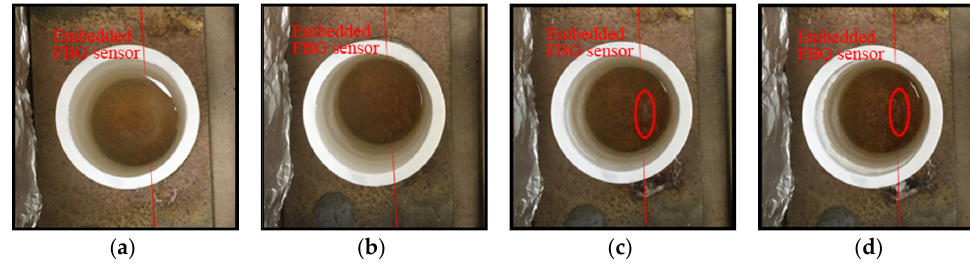
Figure 17. Visual inspections of Sample #4. ( a ) Day 1; ( b ) Day 2; ( c ) Day 3; ( d ) Day 6. Coatings 2017 , 7 , 35